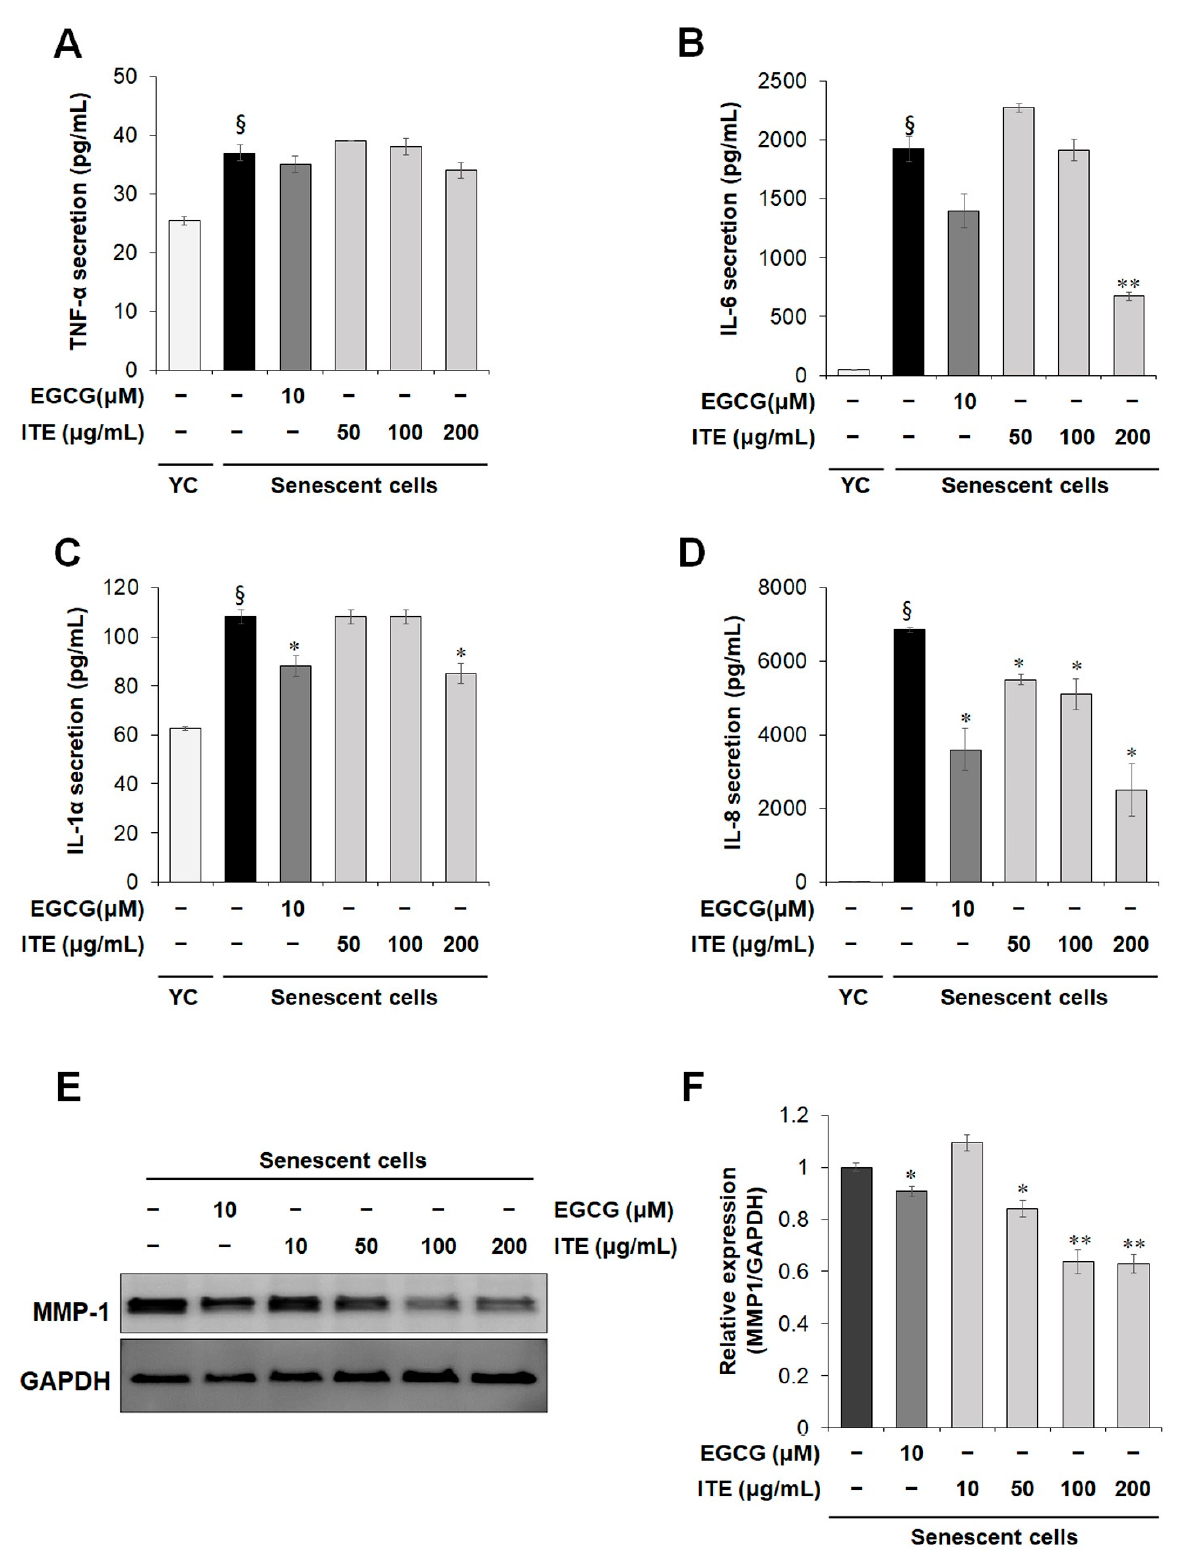
Figure 3. Inhibitory effect of ITE on SASP expression in RS-HDFs. The secretion of TNF- α ( A ), IL-6 ( B ), IL-1 α ( C ), and IL-8 ( D ) in the culture supernatant was measured using a Luminex kit. The ex- pression level of MMP-1 was determined by Western blots. ( E ) Densitometric ratio graph of MMP- 1/GAPDH ( F ). The data are presented as the mean ± SEM of three independent assays. § p < 0.01 compared to young HDF controls, * p < 0.05; ** p < 0.01 compared to RS-HDF controls.